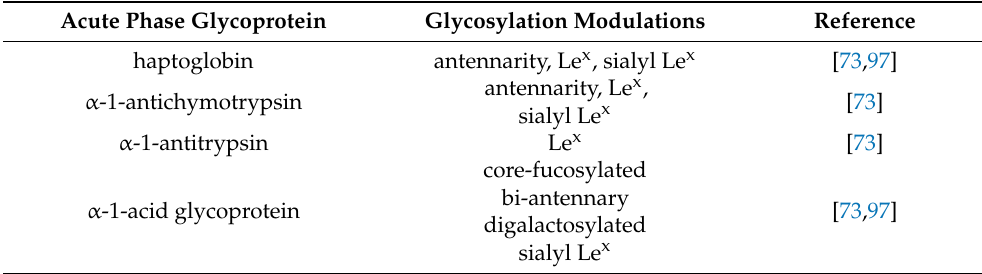
Table 4. Potential acute phase proteins N -glycan biomarkers for ovarian cancer. Le X , Lewis X